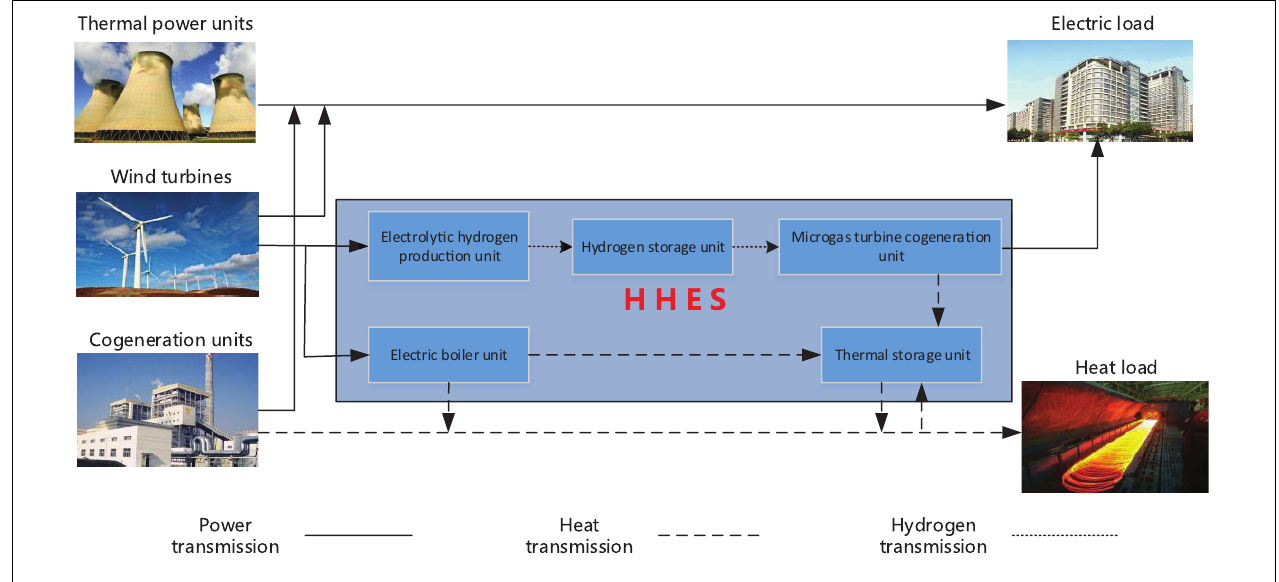
FIGURE 1 | Electricity heat hydrogen system (EHHS) structure